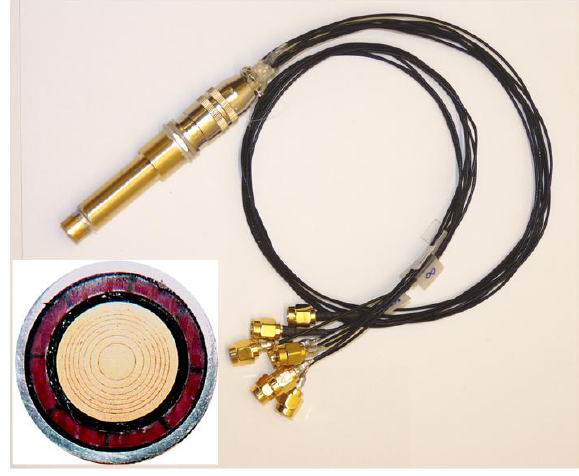
Figure 23. Photograph of the annular array transducer.